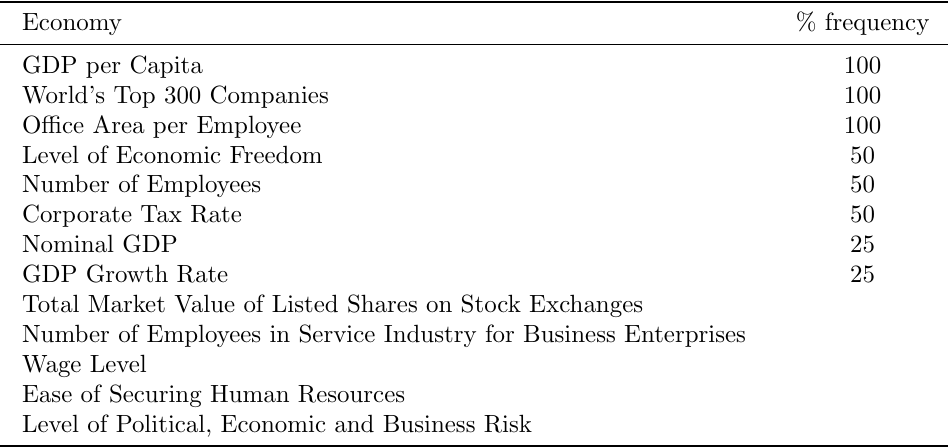
Table A.1: Frequency scores of the sub-sub factors of Economy